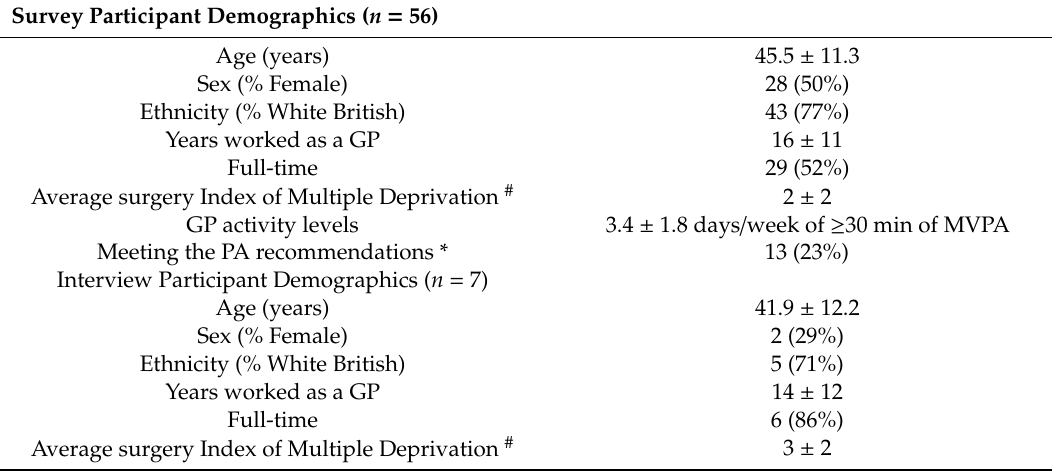
Table 1. Participant demographic data provided by GPs in Liverpool,